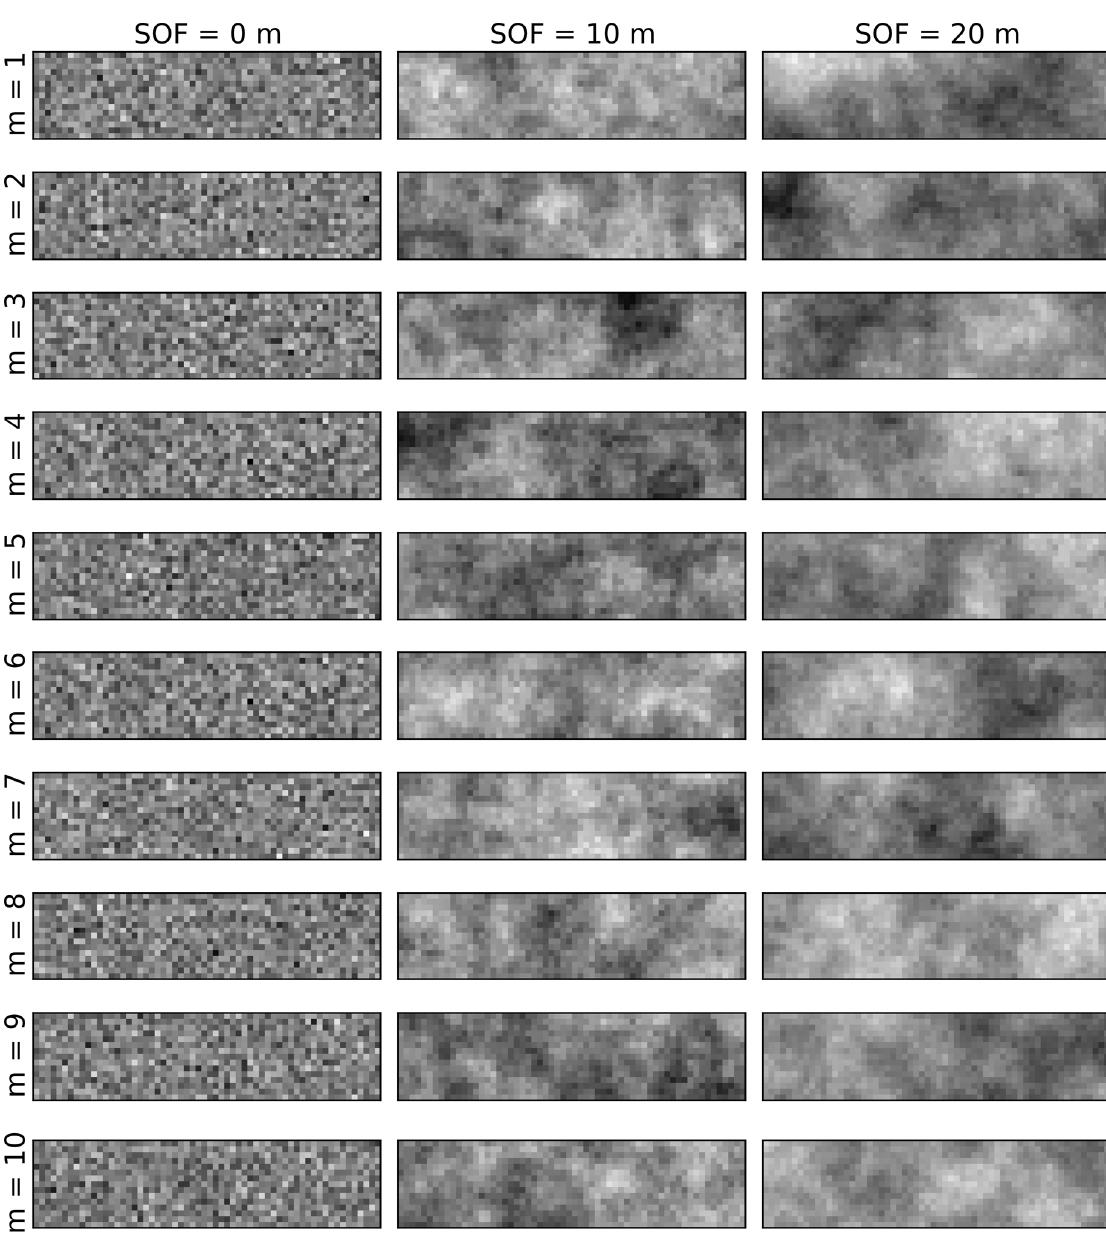
Figure 3. Realization of Gaussian random fields for scales of fluctuation of 0 m, 10 m and 20 m. Table 17. Factors of safety results for spatially varied strength parameters with scale of fluctuation of 0 m. Combination n°